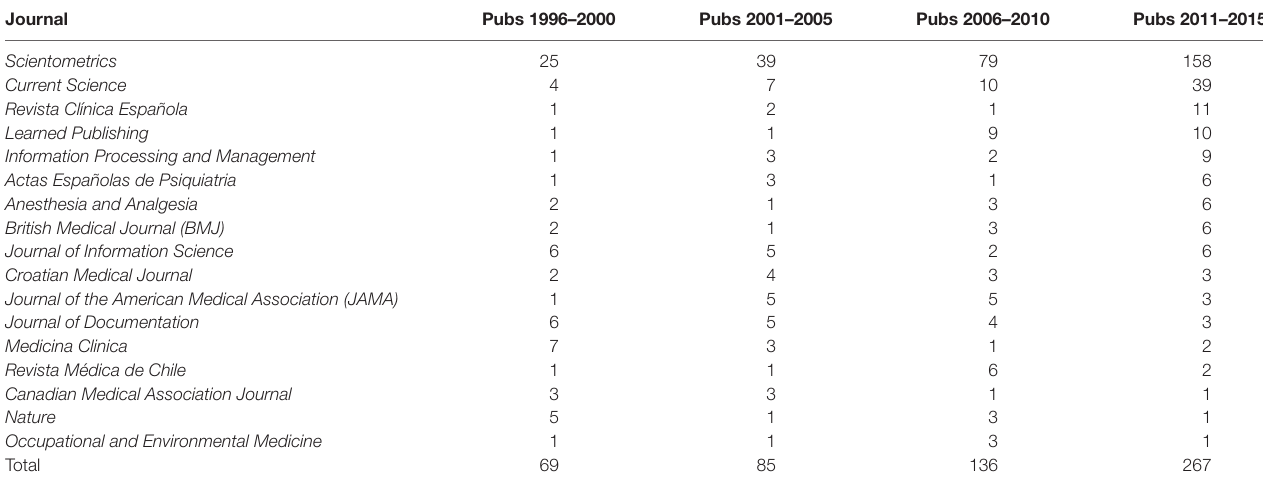
TaBle 2 | Output numbers across journals in Wos on Journal impact Factors, 1996–2015.